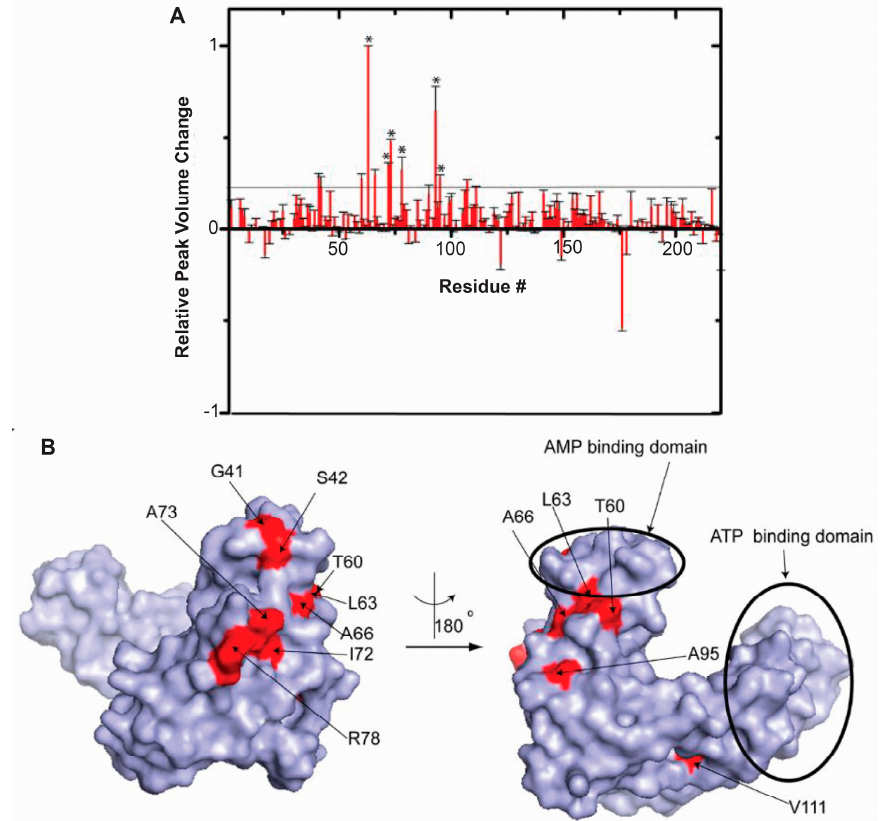
Figure 4. ADK quinary interaction surface does not block the active sites. ( A ) Relative changes in in-cell 1 H- 15 N CRINEPT–HMQC–TROSY peak intensities of [ U - 2 H, 15 N] ADK residues due to ribosome-mediated quinary interactions. The threshold line delineates residues whose NMR peaks undergo significant broadening. Residues that are affected by the interaction of ADK with total RNA are indicated with asterisks. ( B ) Residues involved in quinary interactions (red), mapped onto the molecular surface of ADK (Protein Data Bank, PDB, entry 4AKE), lie in the CORE domain of ADK. Panels ( A , B ) are adapted from Majumder et al. (2015) [14].